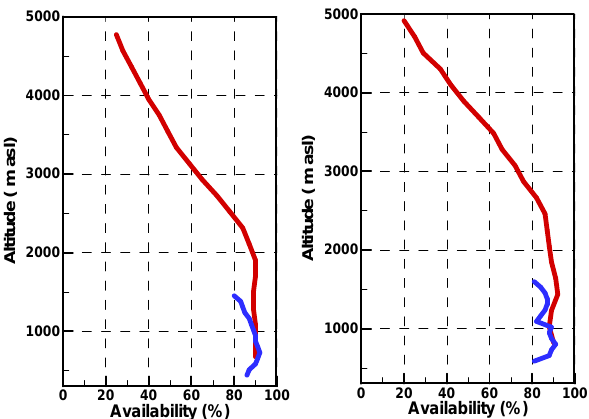
Fig. 3. Vertical profiles of wind speed bias (COSMO2-WP) and standard deviation for wind speed values between 1 and 10ms − 1 (left panels) and wind direction bias and standard deviation for wind speed above 3ms − 1 (right panels), for the first 6 forecast hours, Kleindoettingen, 1 August 2008–31 October